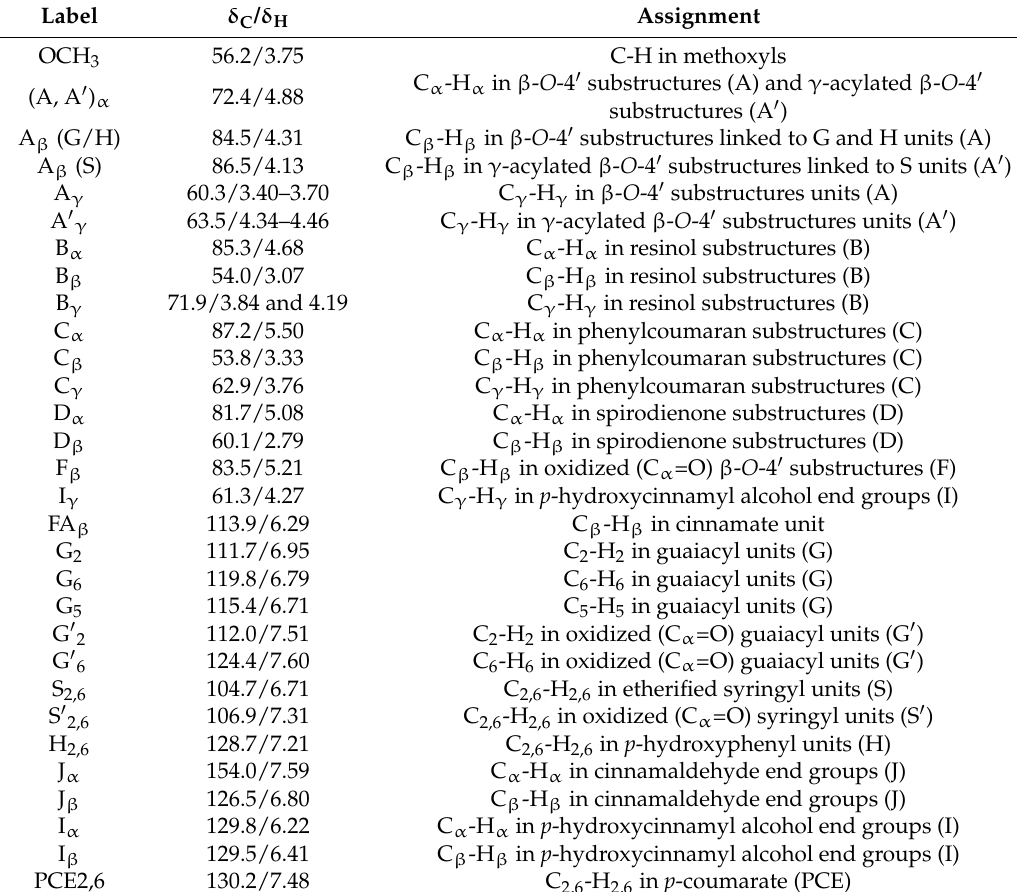
Table 2. Assignment of Main Lignin 13 C- 1 H Cross-signals in the HSQC Spectra of the FMWL and SMWL